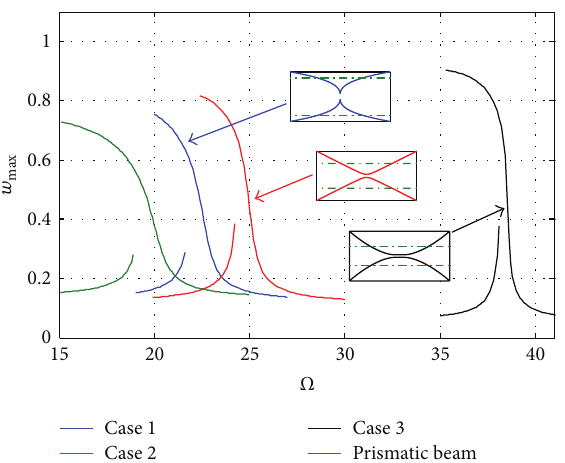
Figure 5: Frequency response curve of different optimized shape: Case 1–Case 3.